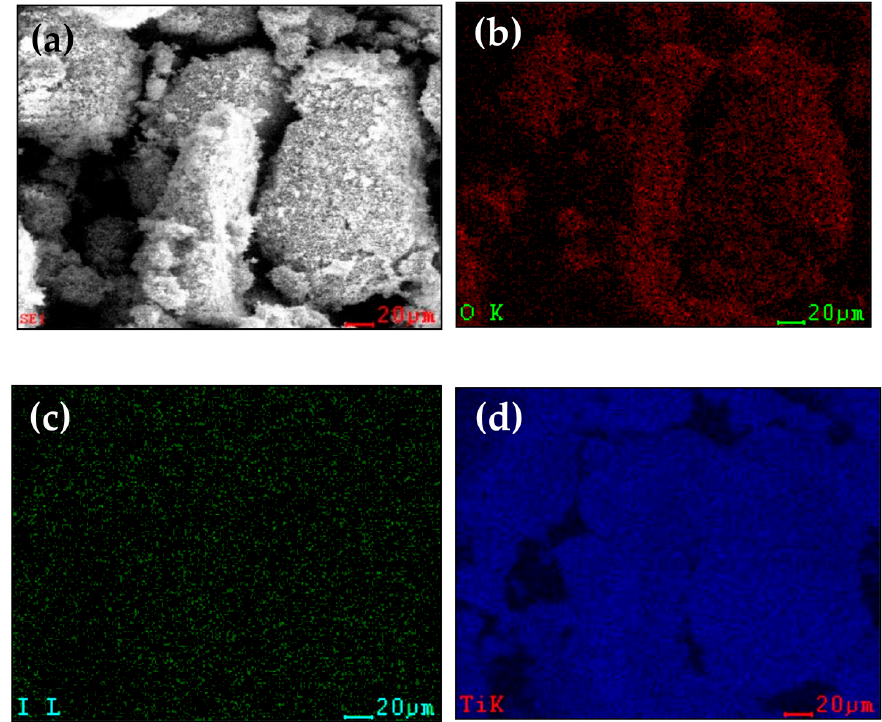
Figure 2. SEM images of ( a ) pristine LTO, ( b ) 0.1 LTO, ( c ) 0.15 LTO, and ( d ) 0.2 LTO.